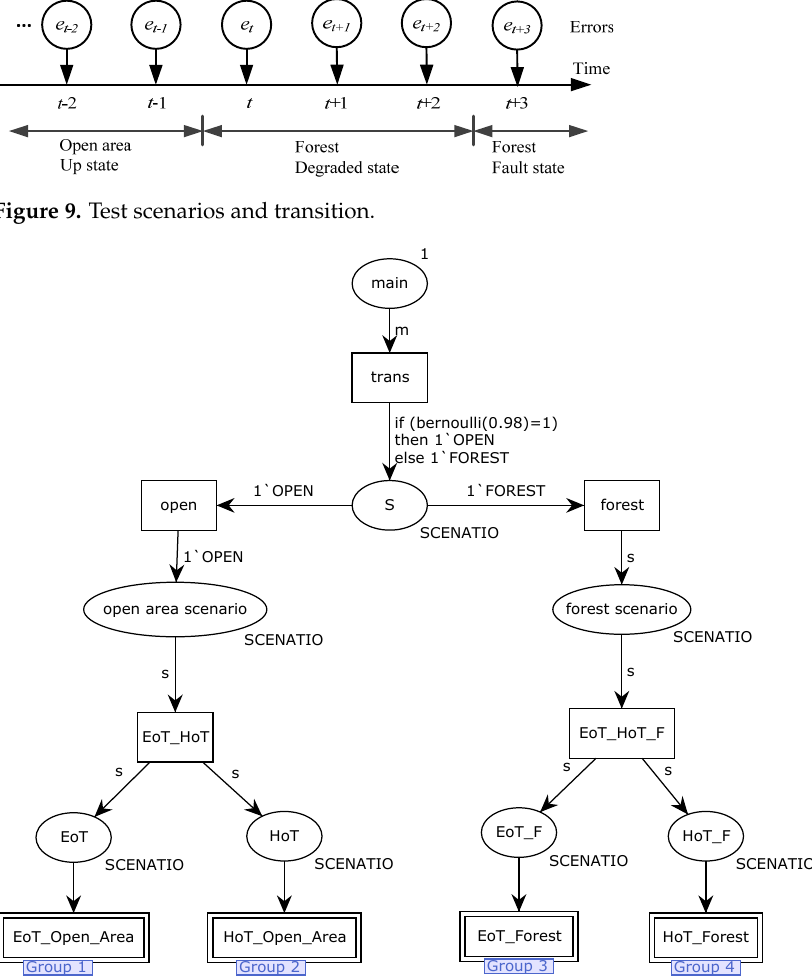
Figure 10. First layer CPN model of scenario in detail.